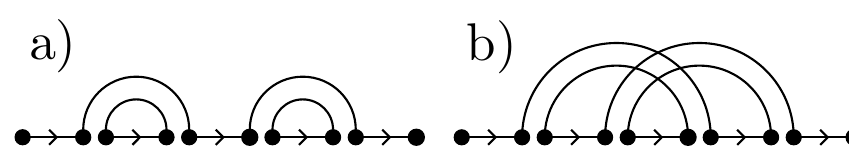
Figure 1 . Examples of planar (a) and non-planar (b) diagrams in the diagrammatic expansion (cid:10) (cid:0) 1 ( (cid:0) 1 ) 4 (cid:11) . For a general matrix model with of the Gaussian model coming from the term Q XQ an arbitrary potential the order of the diagram is given by N L + V (cid:0) P , where V is the number of vertices, L is the number of loops and P is the number of propagators comprising the diagram. This shows that the dominant contribution comes from the planar diagrams. The contribution from the non-planar diagram on (b) is of order N (cid:0) 2 , thus vanishes in the large N limit. propagator